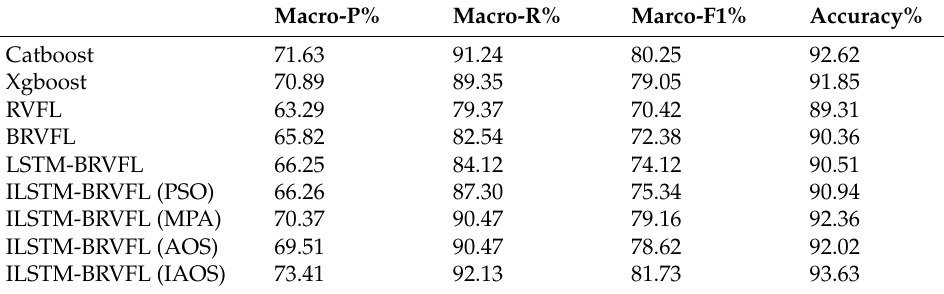
Table 6. Evaluation indicators of the contrast model on w 2